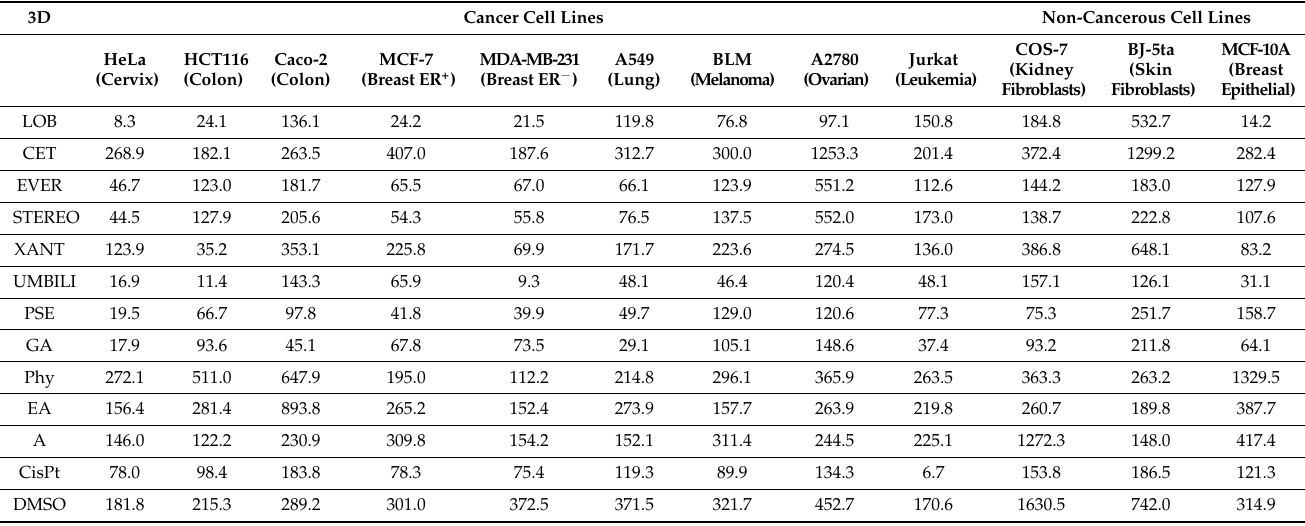
Table 3. IC 50 values ( µ g/mL or µ M) list from 3D spheroids screening